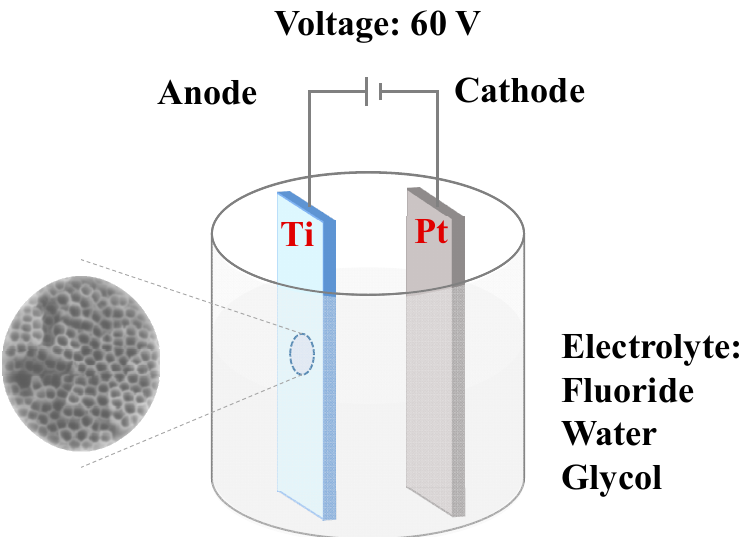
Figure 1. Schematic illustration of an electrochemical anodic oxidation